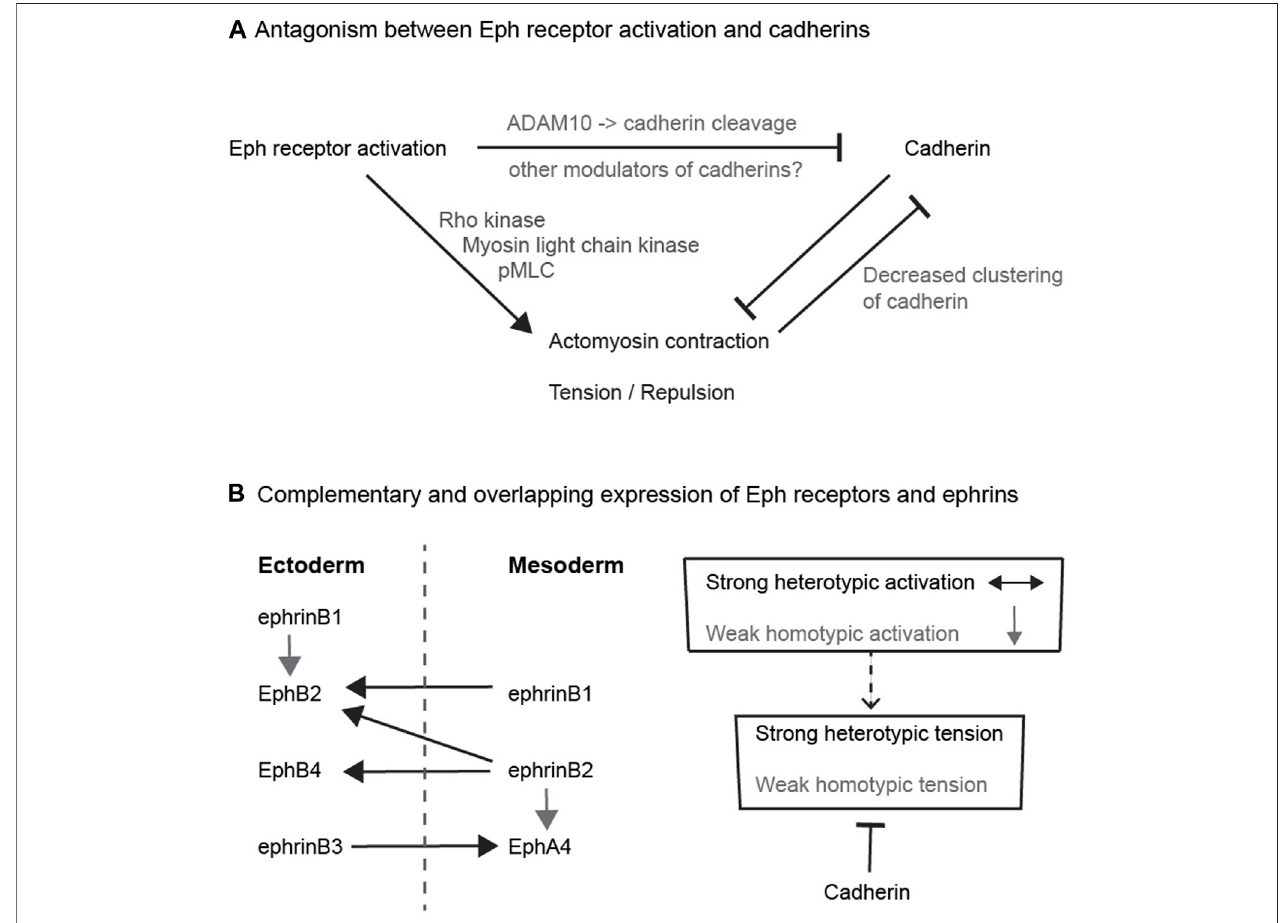
FIGURE2| PotentialrelationshipsbetweenEphreceptorsandcadherins (A) AntagonismbetweenEphreceptoractivationandcadherins.Thediagramdepictsthe antagonism between adhesion and cortical tension, and pathways that have been found to link Eph receptor activation to decreased cadherin function. (B) Complementary and overlapping expression of Eph receptors and ephrins. The left hand diagram depicts the expression pattern and interactions of Eph receptors and ephrins in ectoderm and mesoderm in Xenopus . Each tissue expresses a combination of Eph receptors and ephrins that leads to strong heterotypic activation (black arrows) of Eph receptors in both directions that underlies increased cortical tension and cell repulsion. In addition, there is weaker homotypic activation of Eph receptor by low-level or low-af fi nity ephrin co-expressed within each tissue (grey arrows). The right hand diagram depicts that cadherins may serve to suppress the weakerhomotypictensionduetooverlappingEph-ephrinexpression,whereasstrongheterotypicEphreceptoractivationdominatesovercadherin-mediatedadhesion.